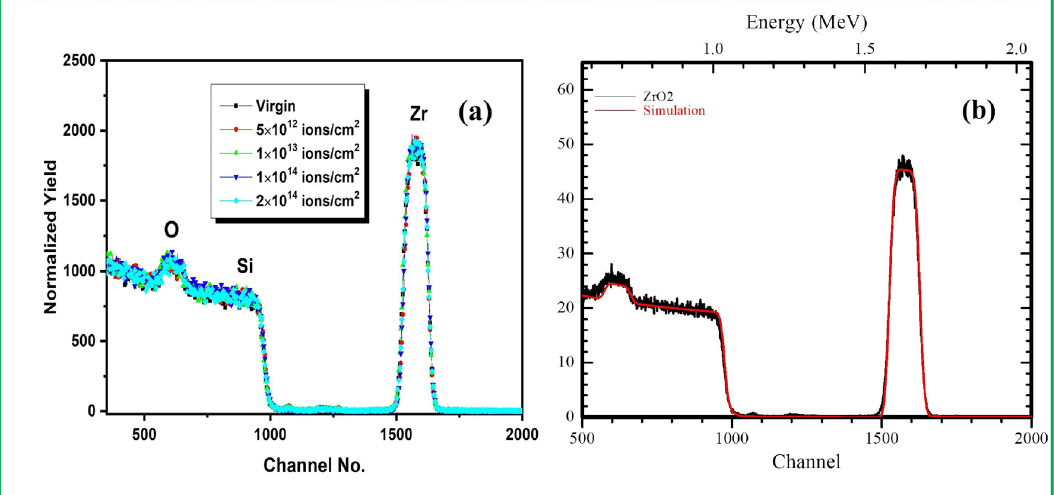
Figure 3. RBS spectra of ( a ) virgin and irradiated with 100 MeV Ni ions at fluence 5 × 10 12 , 1 × 10 13 , 1 × 10 14 and 2 × 10 14 ions/cm 2 of ZrO 2 samples and ( b ) Simulated Rutherford backscattering spectra of virgin ZrO 2 thin